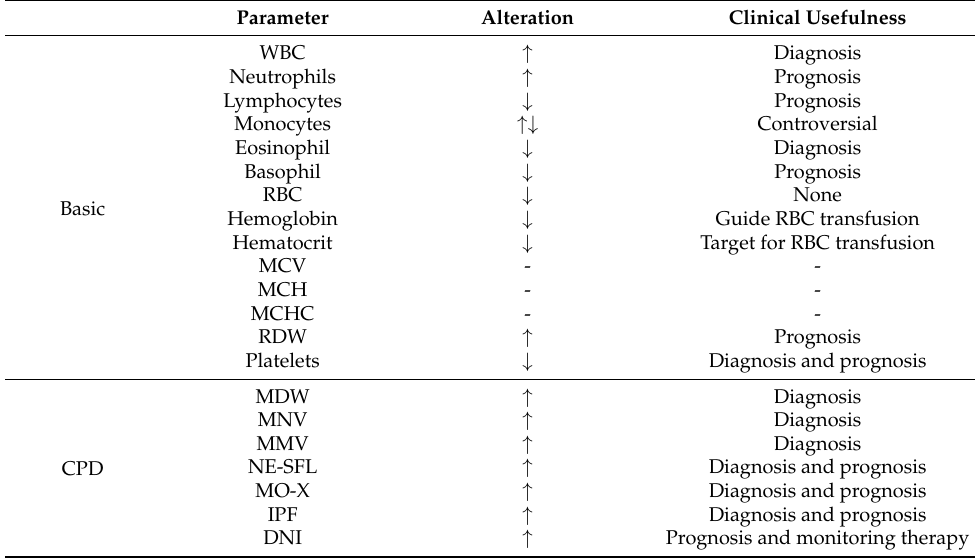
Figure 3. Pros and cons of CBC parameters as biomarkers of sepsis. Table 1. Clinical usefulness of CBC parameters for